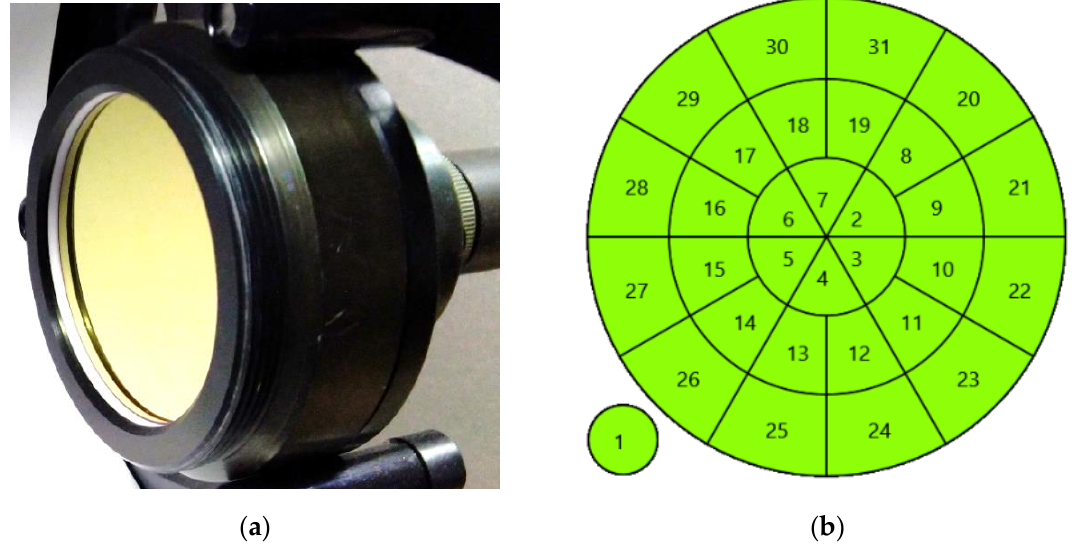
Figure 2. Bimorph mirror used in experiments: ( a ) Mirror photo; ( b ) electrodes structure. The num- bers indicate the channels of the mirror. The first electrode, conventionally shown in the lower-left corner, has the dimensions of the mirror aperture and is used to control the defocusing of the wave- front. Table 1. Main parameters of the bimorph mirror.